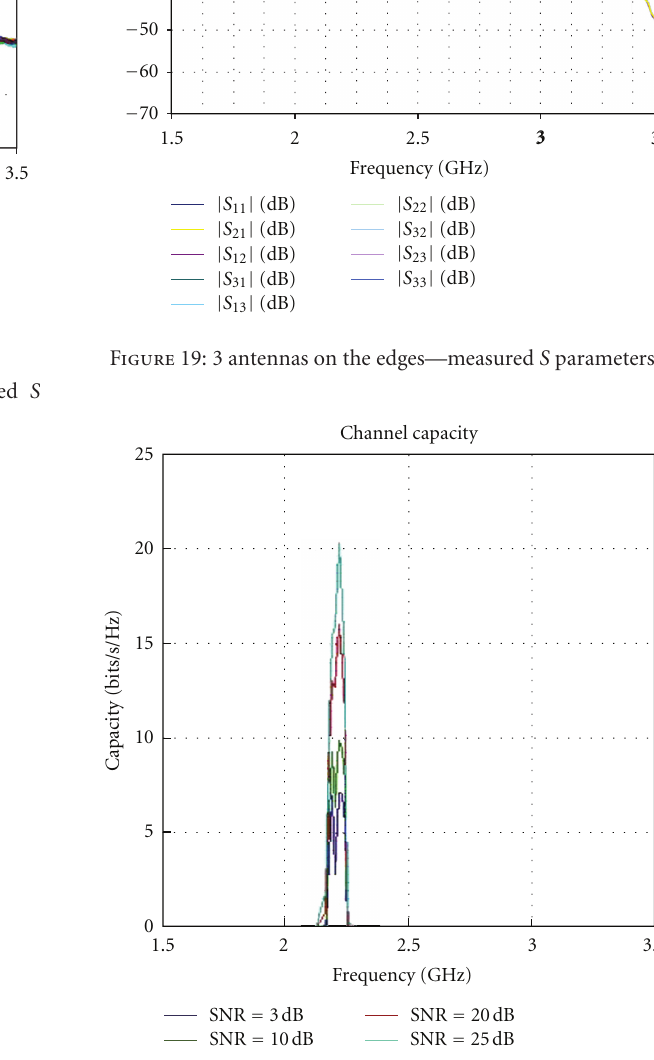
Figure 20: 3 antennas on the mid of the faces—calculated channel capacity (from channel transfer